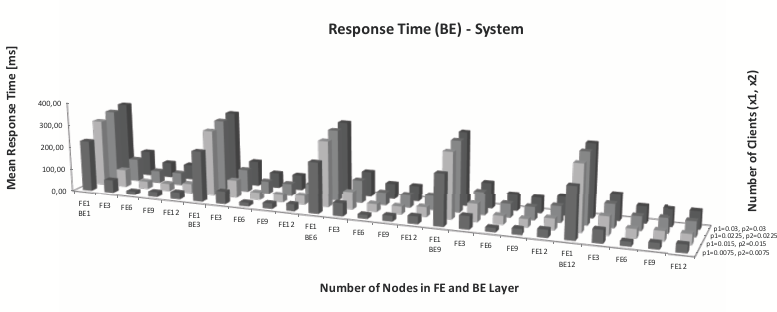
Figure 5. Response time for different number of nodes in Back-End (BE) and Front-End (FE)